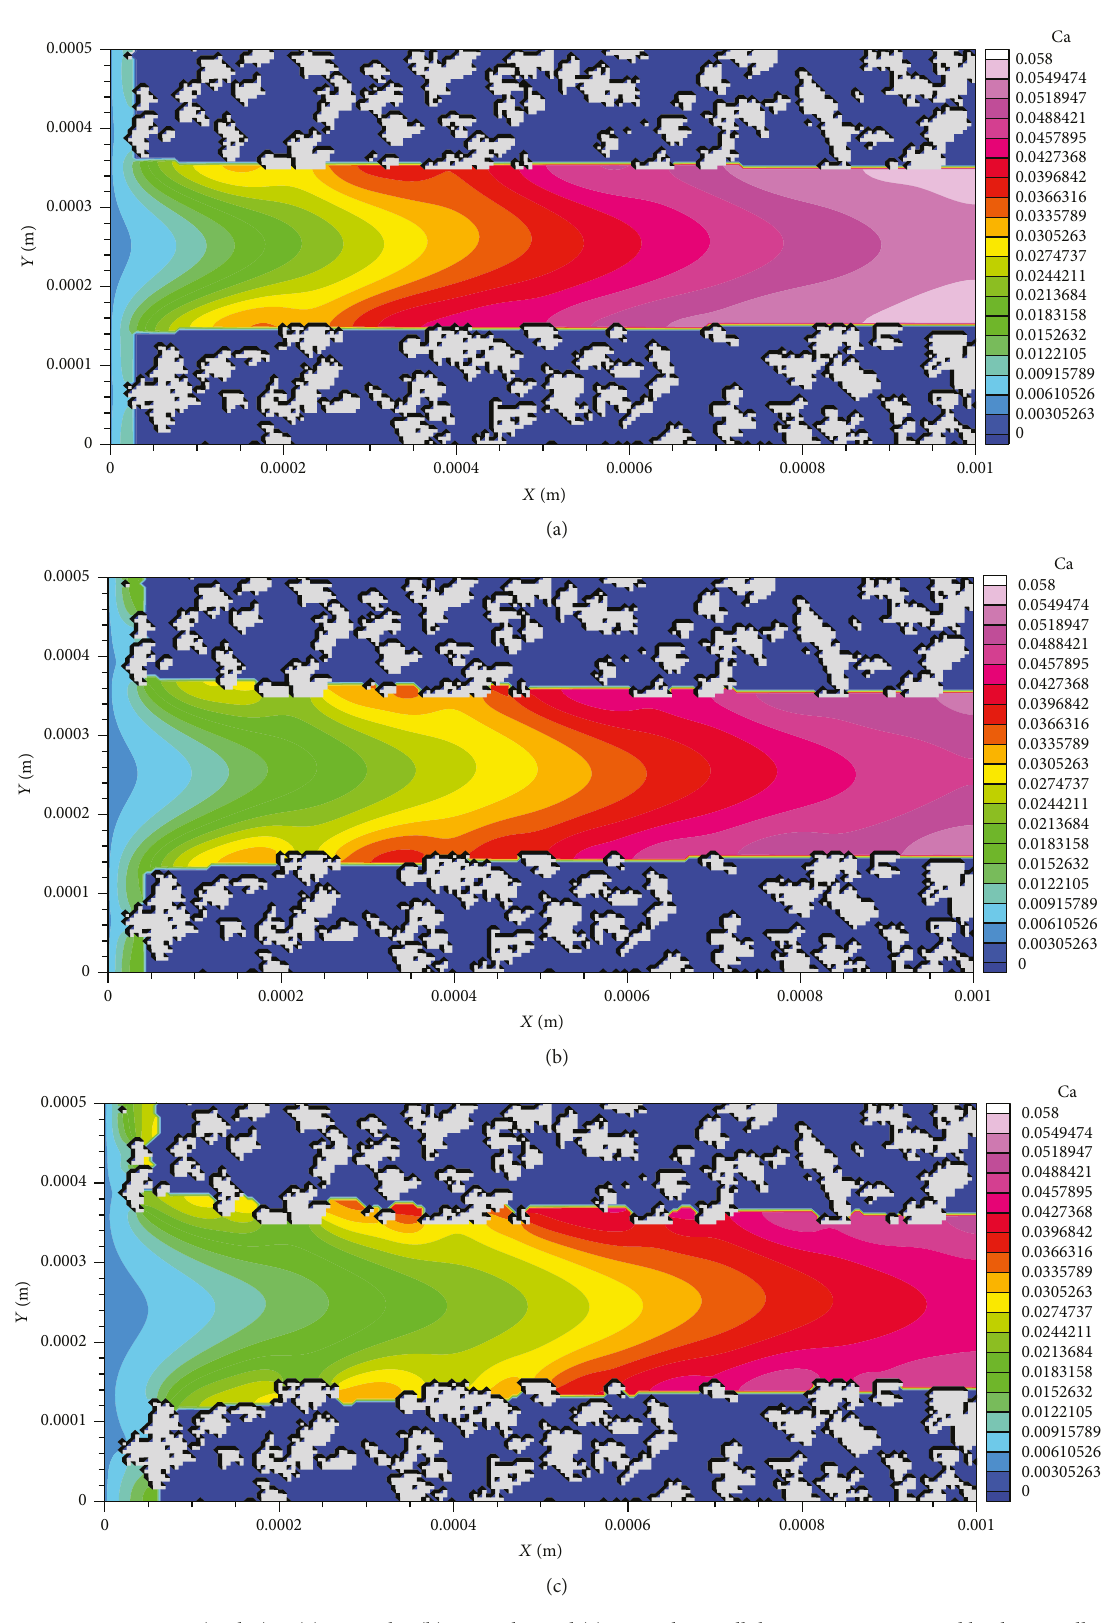
Figure 14: Ca concentrations (mol/L) at (a) t = 1 5 hr, (b) t = 4 9 hr, and (c) t = 8 7 hr. In all three cases, Pe=2.6 and kaolinite is illustrated in light